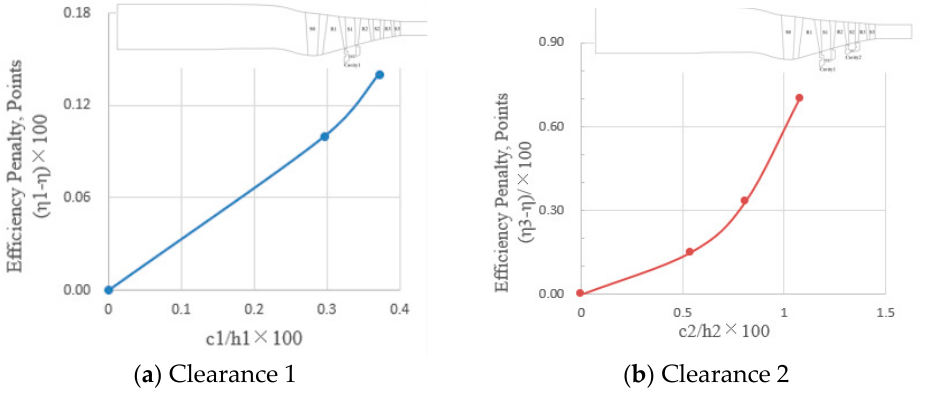
Figure 11. Efficiency penalty for varying seal-tooth clearance.